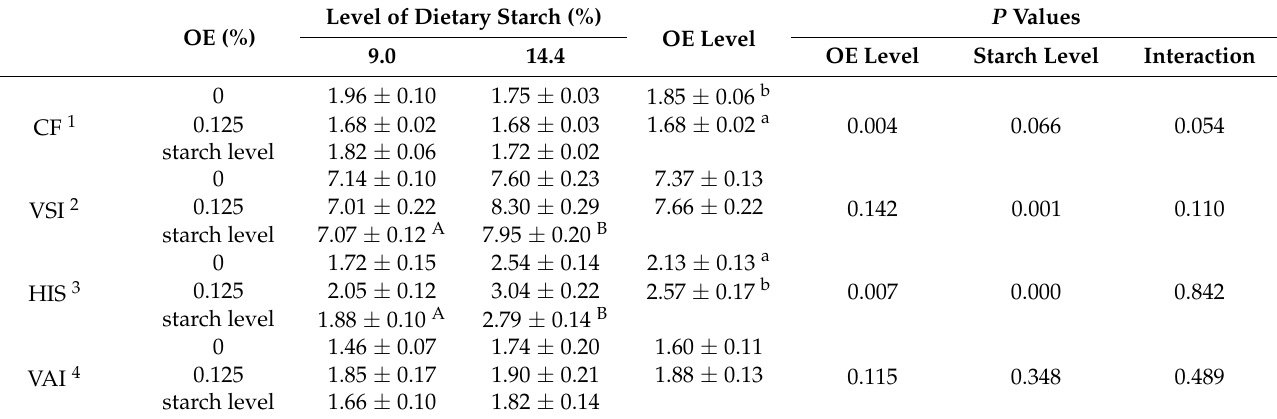
Table 4. Effects of experimental diets on morphometric parameters in largemouth bass.